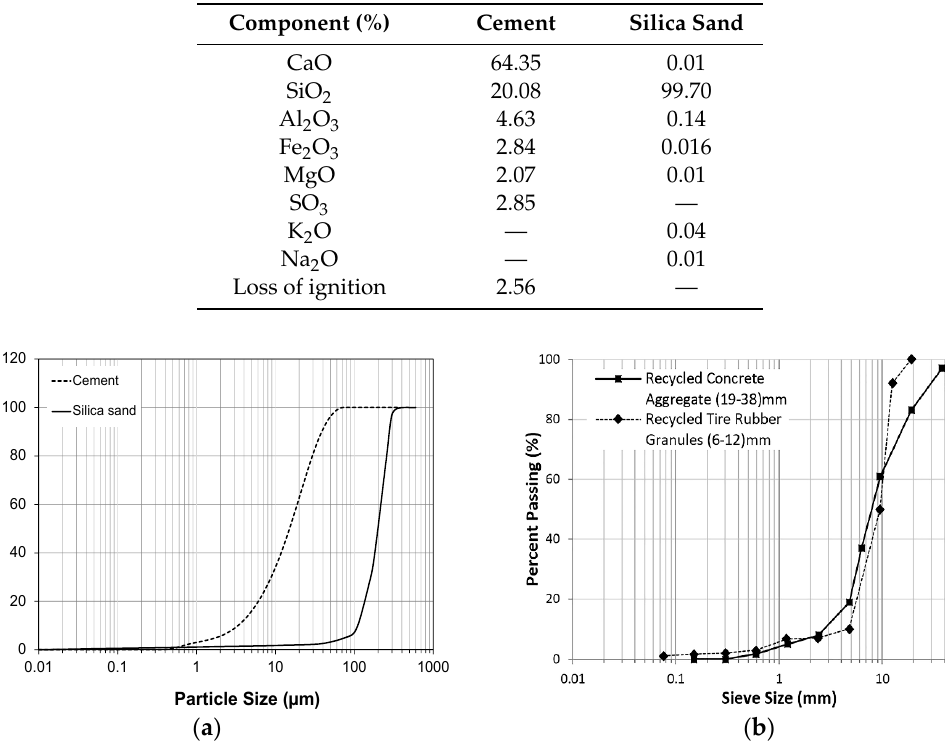
Table 1. Chemical composition of cement and silica sand.